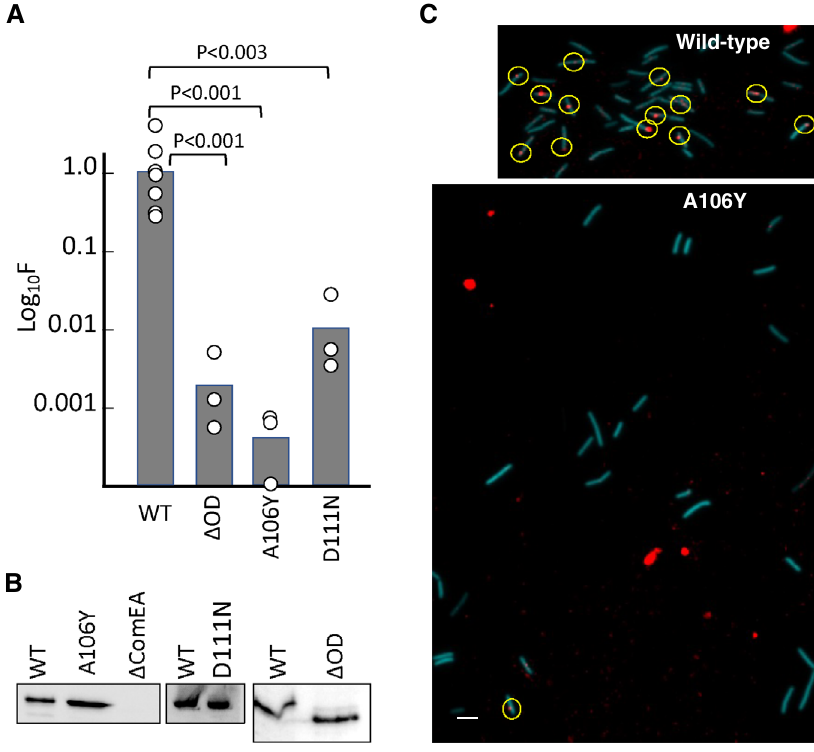
Δ comEA extracts were included as controls for the identity of the ComEA signals. Panel C shows typical epi fl uorescent images from the wild-type (BD9007) and its isogenic A106Y mutant equivalent, after transformation with rhodamine-labeled lambda bacteriophage DNA for 45-min. Competence-expressing cells were identi- fi ed by CFP fl uorescence (pseudocolored cyan) and detectable cell-associated rhodamine-tDNAsignalsarecircled.Forthewildtype,13outof42cellsexhibitedat least one red dot, while for the 23 mutant cells only one barely detectable cell- associated dot was observed. The large red blotches in the lower panel are not associatedwithcellsandareduetocontaminating fl uorescentmaterialofunknown origin. The scale bar on the lower left of the image corresponds to 1 micron. The microscopy and Western blotting experiments in panels B and C were each repe- ated three times with closely similar results. Source data are provided as a Source Data fi